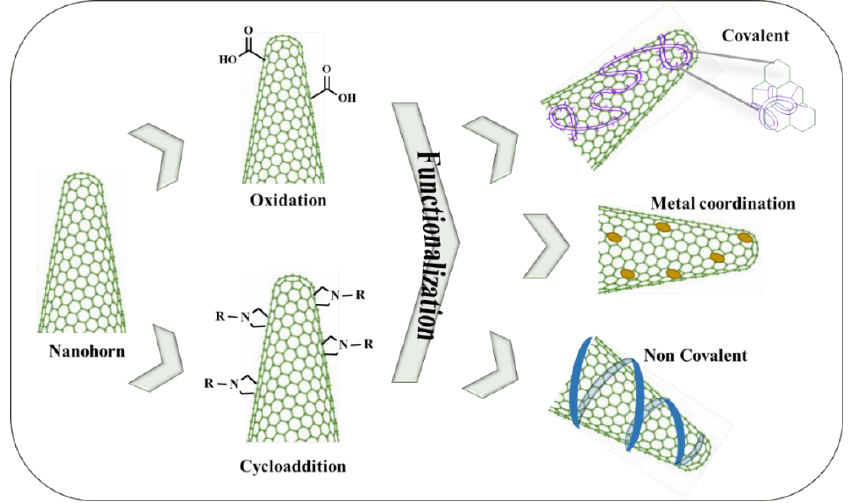
Figure 3. Representation of the main Carbon Nanohorns functionalization